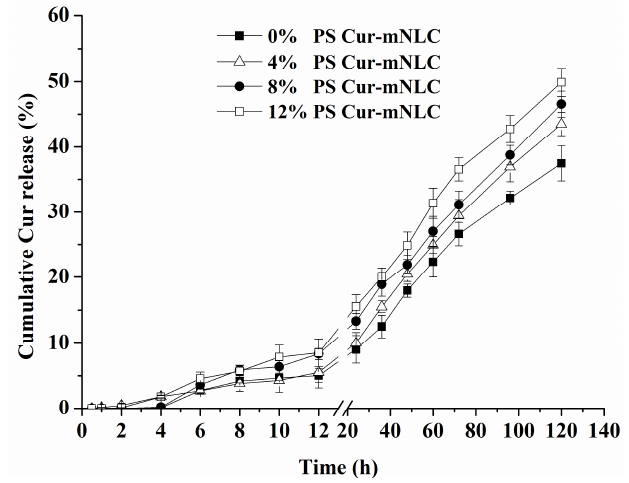
Figure 3. In vitro release profiles of different PS-containing Cur-mNLCs (0%, 4%, 8% and 12% PS molar ratios) in 200 mL of modified phosphate buffered saline (PBS) buffer solution (pH 7.4, containing 0.5% sodium dodecyl sulfate (SDS)) at 37 °C for 120 h (mean ± SD, n = 3). The cumulative drug release of Cur-mNLCs was all below 50% at 120 h. All preparations displayed a similar release manner without significant differences ( p > 0.05).